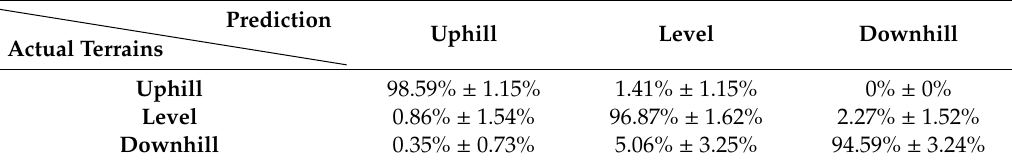
Table 6. Confusion matrix for the classification results of the SVM using both the EMG and GRF features. The element is presented as average ± SD.